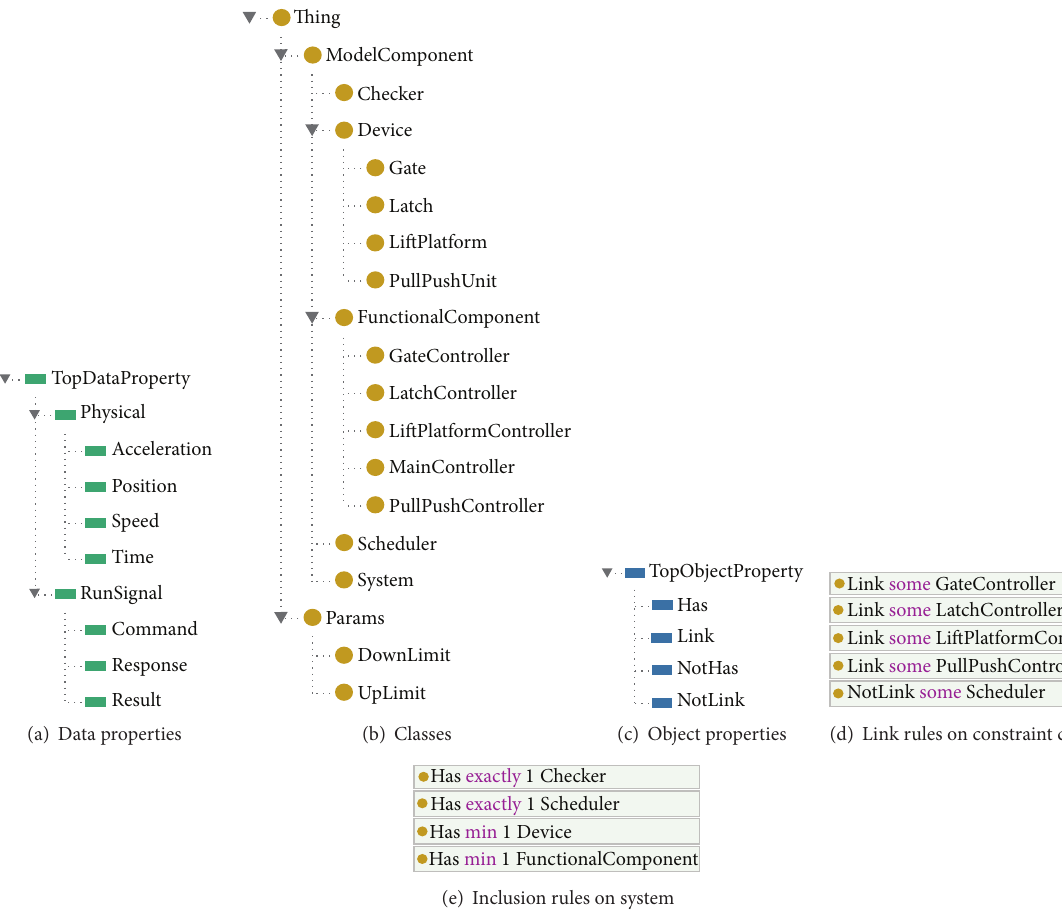
Figure 6: The ontology of gate control